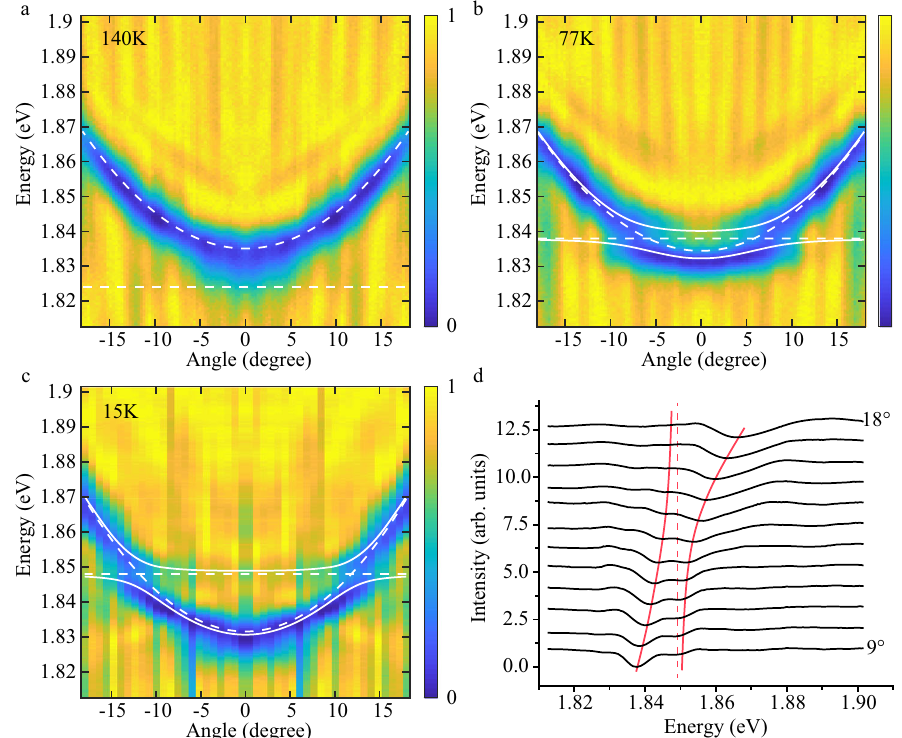
Fig. 2 Temperature dependent cavity coupling to excited-state excitons. a – c Angle resolved re fl ection at different temperatures of 140, 77, and 15 K. The dashed lines indicate the bare cavity and exciton dispersions, while the solid lines correspond to the resulting dispersion relations of the two polaritons induced by the strong coupling between the excitons and the cavity photons. d Line cut from the 15 K data between 9 (cid:4) and 18 (cid:4) . Those data have y axis offset for clarity. A clear anti-crossing is observed (red trend lines). The extracted Rabi splitting is 7.7 meV. The dashed line shows the 2 s exciton energy at 1.848